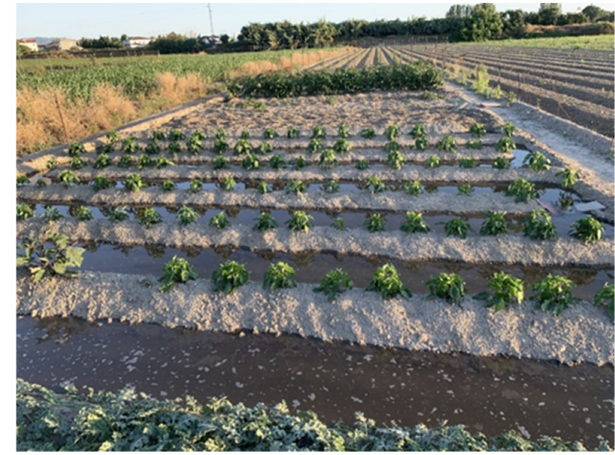
Figure 17. Place where tests were carried out.